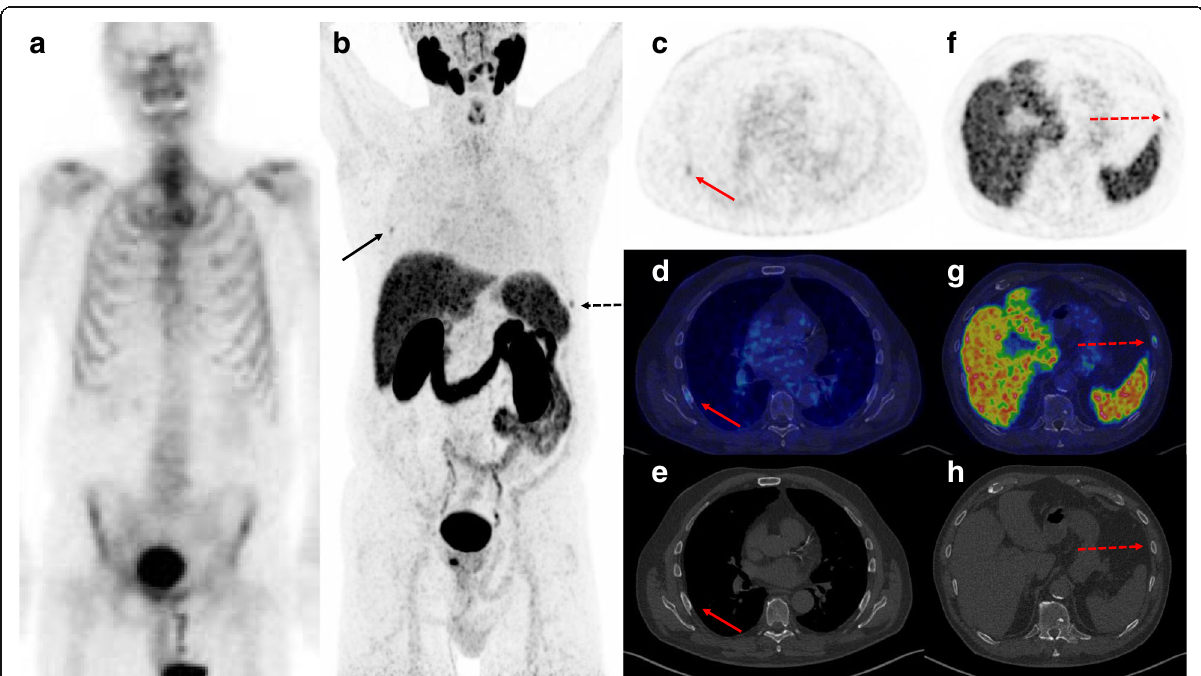
Fig. 2 Example of a patient (PSA 13, Gleason score 9, T2b) with no bone metastases according to BS (shown in anterior projection) ( a ) but with two suspicious lesions in the seventh right rib and the eighth left rib according to the 68 Ga-PSMA-11 PET/CT. Except for the 68 Ga-PSMA-11 uptake in the ribs and the prostate, no other suspicious lesions were observed. The 68 Ga-PSMA-11 PET MIP showed two rib lesions ( b ); the full arrow indicates a bone lesion in the seventh rib on the right side with corresponding axial 68 Ga-PSMA-11 PET ( c ), 68 Ga-PSMA-11 PET/CT fusion ( d ) and CT ( e ). The hatched arrow indicates a bone lesion in the left eighth rib with corresponding axial PSMA PET and corresponding axial 68 Ga-PSMA- 11 PET ( f ), 68 Ga-PSMA-11 PET/CT fusion ( g ), and CT ( h ). The patient had no bone metastases according to the BVC: the patient had a radical prostatectomy without any systemic treatment, and the post-prostatectomy PSA level was < 0.1 ng/mL and remained so until this study was